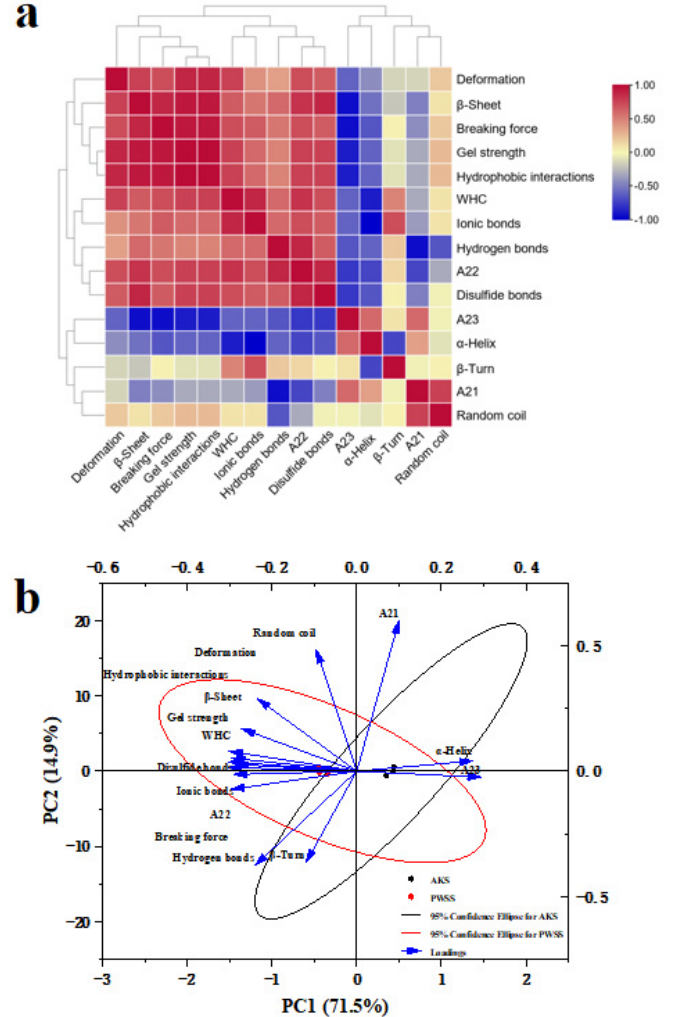
Figure 7. The correlation analysis and principal component analysis (PCA): ( a ) Correlation analysis; ( b ) the score scatter and loading plot of PCA. PWSS, Pacific white shrimp surimi; and AKS, Antarctic krill surimi.